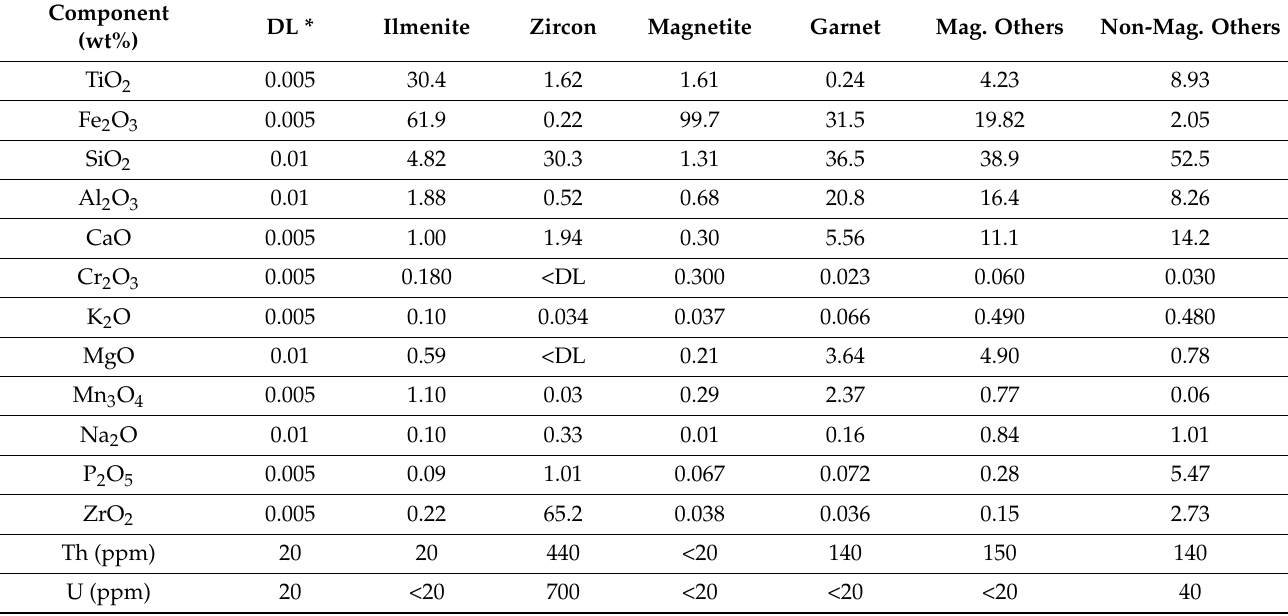
* DL = detection limit for each component. <DL = below detection